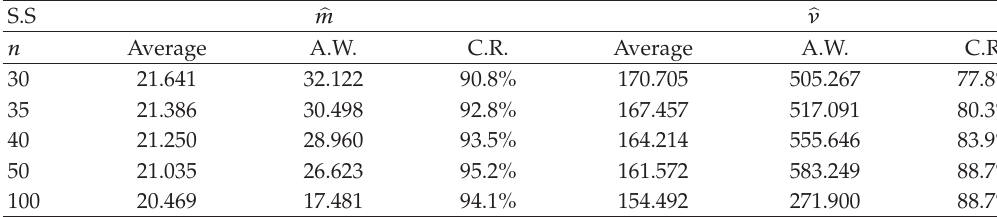
Table 6: Grouped data: τ 1 (cid:8) − 3 . 5, τ 2 (cid:8) − 0 . 5, τ 3 (cid:8) 2 . 5, τ 4 (cid:8) 5 . 5, τ 5 (cid:8) 8 . 5.